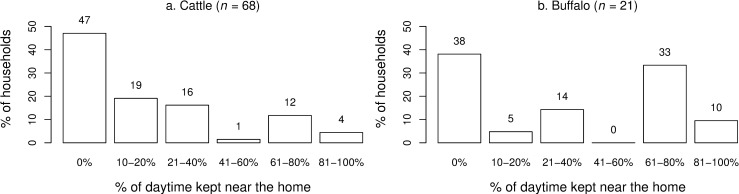
Proportions of smallholder households reporting the amount of daytime (%) that large ruminants were kept near the homestead in 2018, Lao PDR.(a) cattle (b) buffalo.